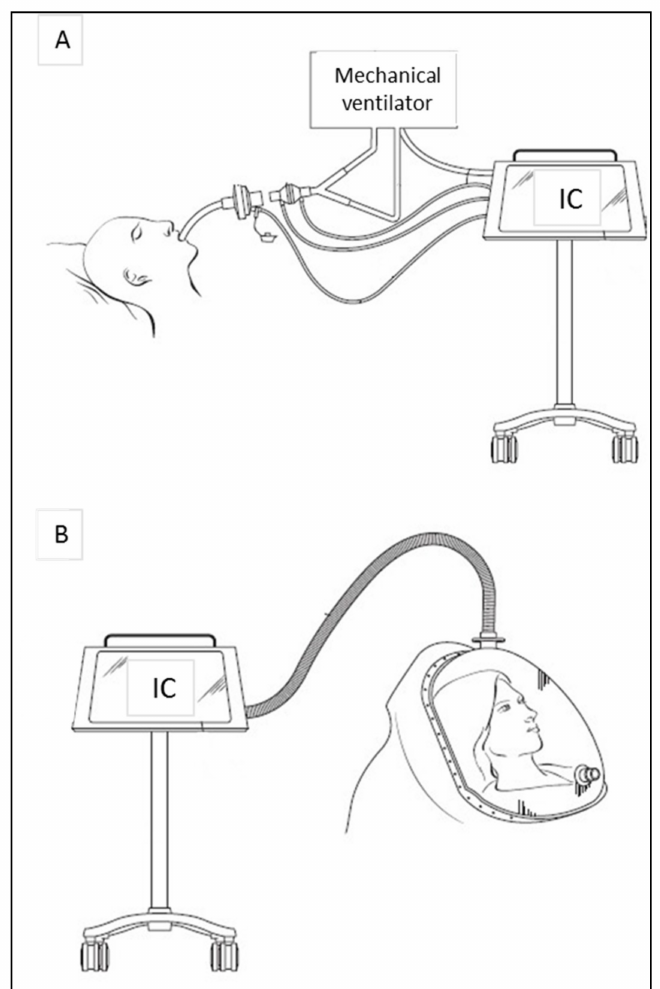
Figure 1. Indirect calorimetry on mechanically ventilated patient ( A ) and on spontaneous breathing patient in canopy mode ( B ). In mechanical ventilation the gas sampling is acquired by the circuit connecting the endotracheal tube to the ventilator and measured by ‘breath-by-breath’ or mixing chamber analyses. In spontaneous breathing mode, the subject is placed under a clear canopy with a plastic drape to avoid air leakage. Breath exchanges are collected by the calorimeter for gas analysis and enable calculation of REE using Weir’s equation (REE (kcal / day) = [(VO 2 × 3.941) + (VCO 2 × 1.11)] ×